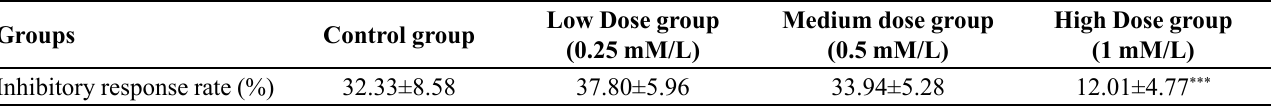
TABLE IV - Inhibitory Effect of Iguratimod on Diclofenac metabolism in human recombinant CYP2C9 yeast cells